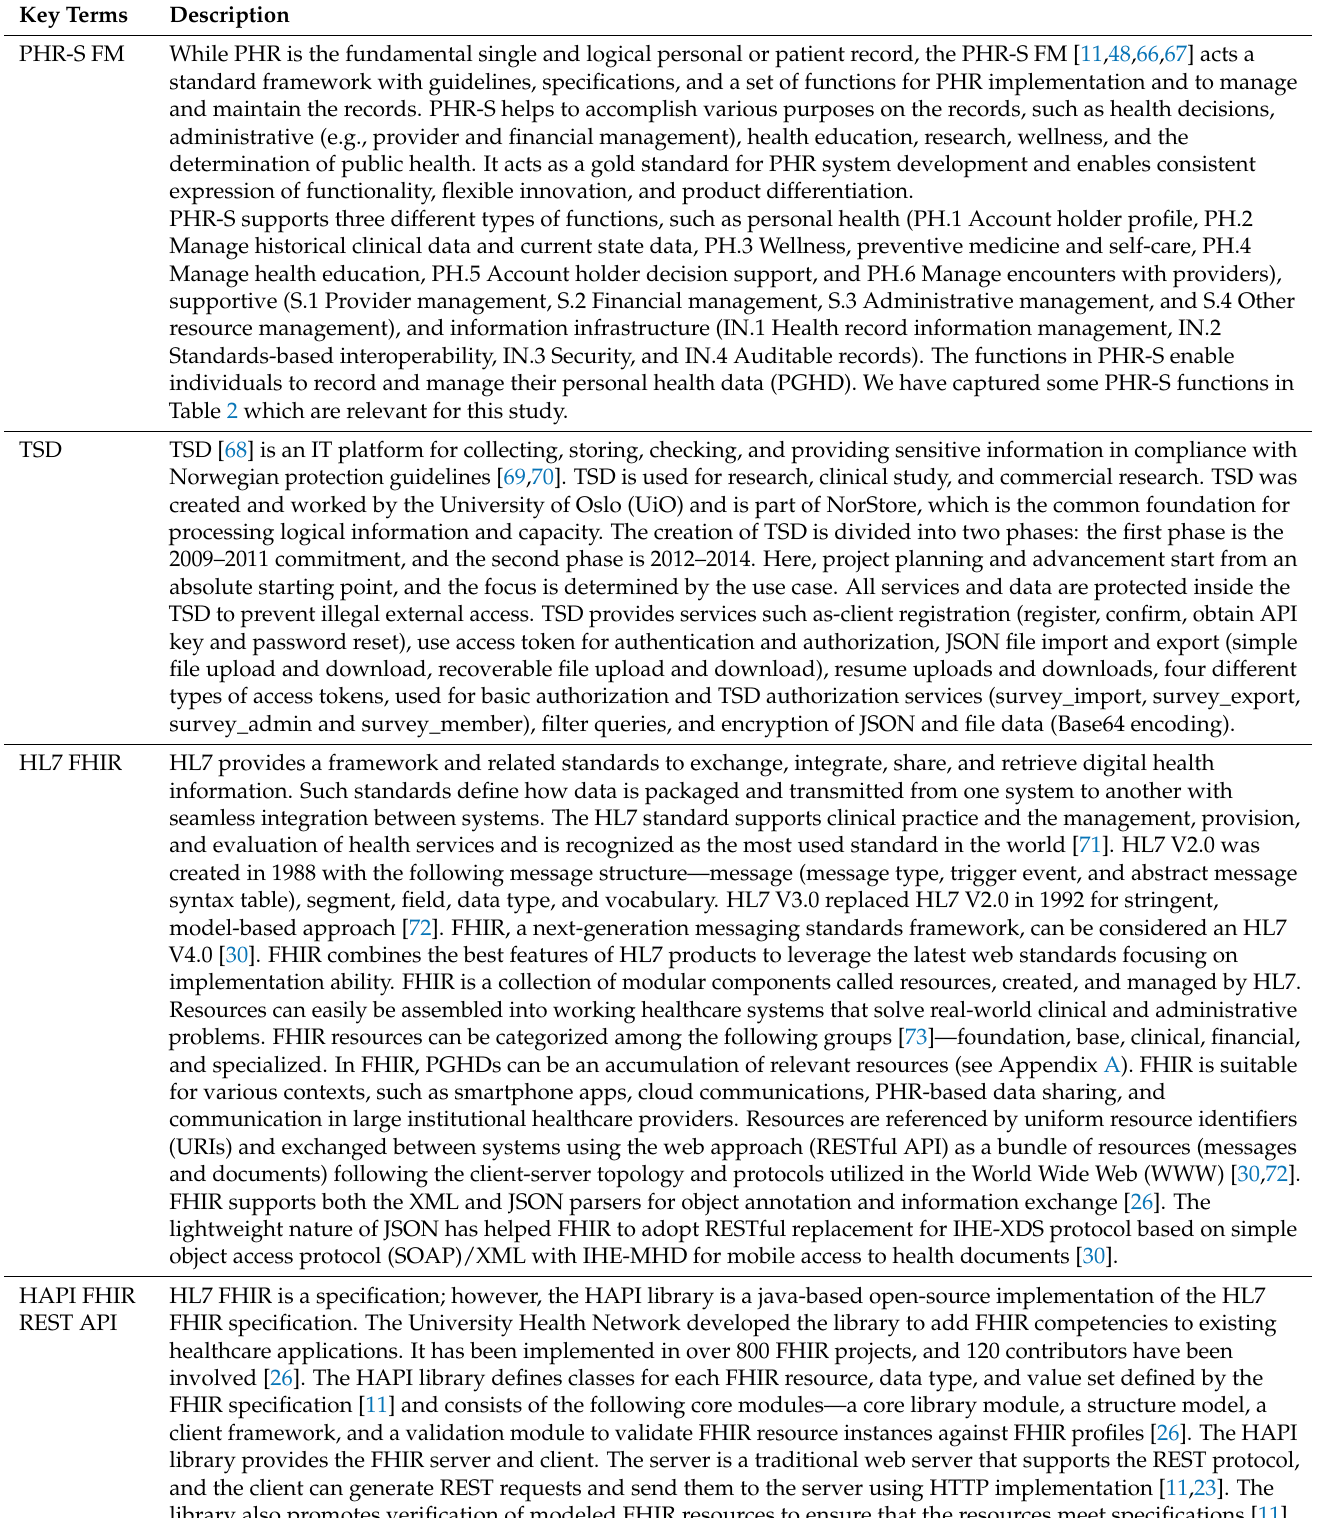
Table A1. The high-level descriptions on the used key